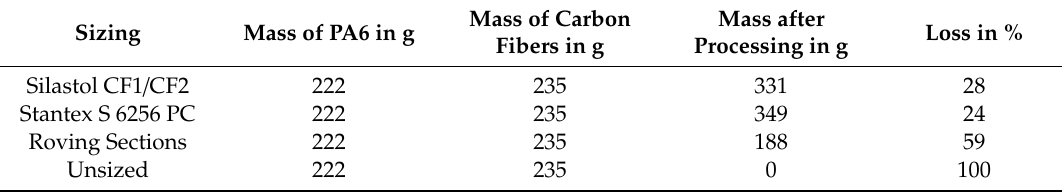
Table 2. Carbon fiber weight yield after the carding